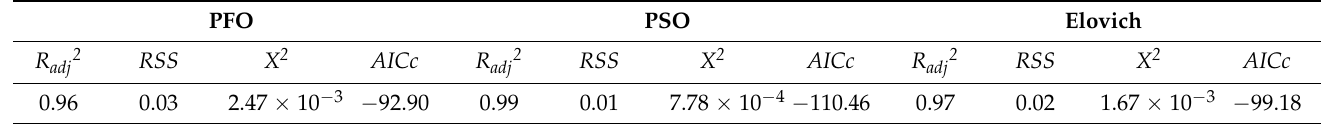
Table 3. Adsorption kinetics statistics obtained for the treatment under optimized conditions.